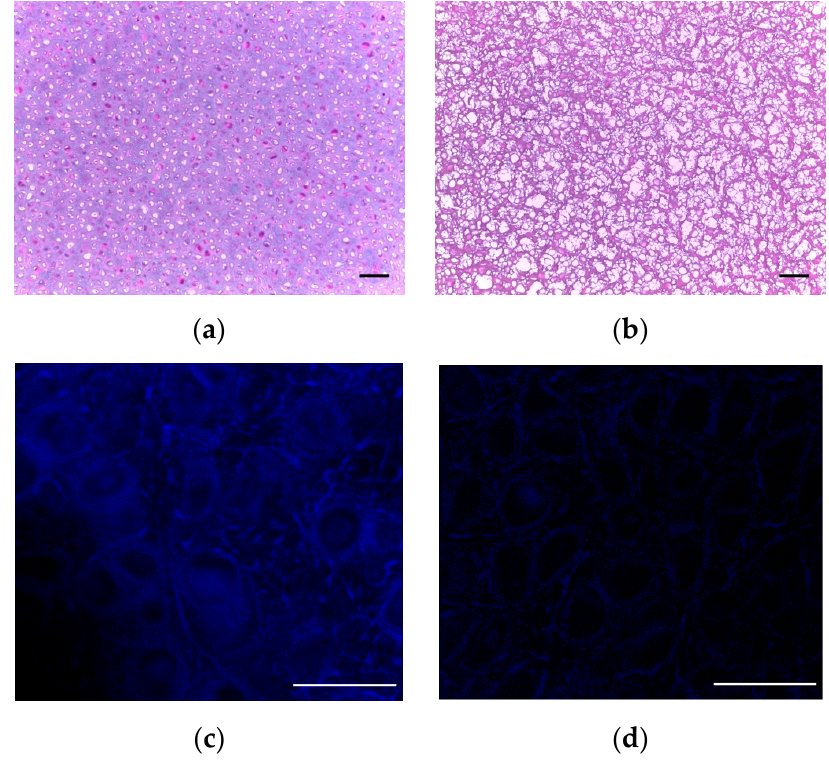
Figure 3. Visualization of cartilage tissue by histology. ( a ) Nondecellularized porcine cartilage stained with H&E and ( b ) H&E stain on final decellularized cartilage, transverse image. ( c ) Hoechst stain to fluorescently visualize DNA (blue). Arrow indicates nucleus of a cell. ( d ) Hoechst stain shows absence of DNA after decellularization process (see absence of blue). Scale bar = 100 µ m for ( a , b ); scale bar = 50 µ m for ( c , d ). Adapted with permission from Ref. [49] 2021, Stone and